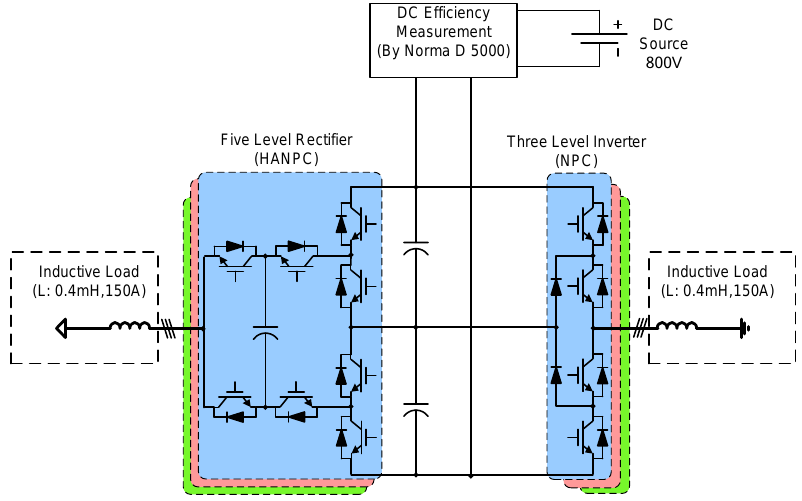
Figure 11. Experimental setup for the full-power test.